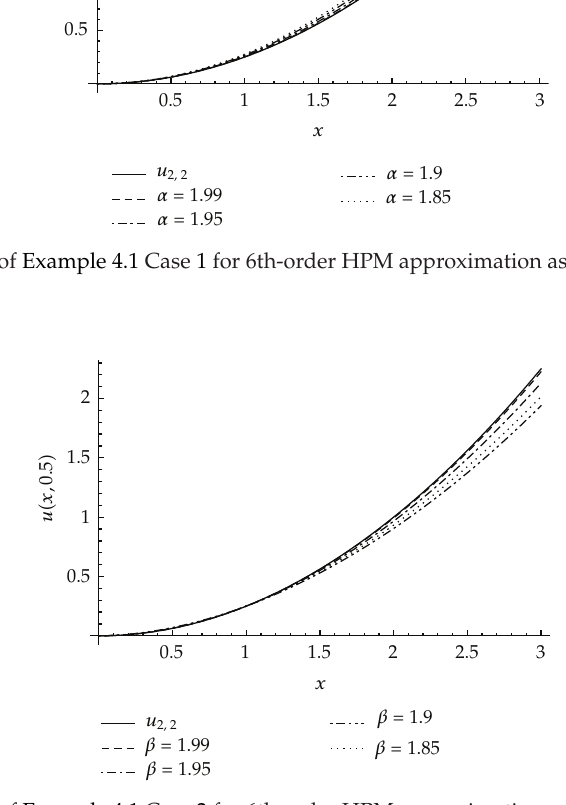
Figure 2: u (cid:2) x, 0 . 5 (cid:3) of Example 4.1 Case 2 for 6th-order HPM approximation as parameterized by β